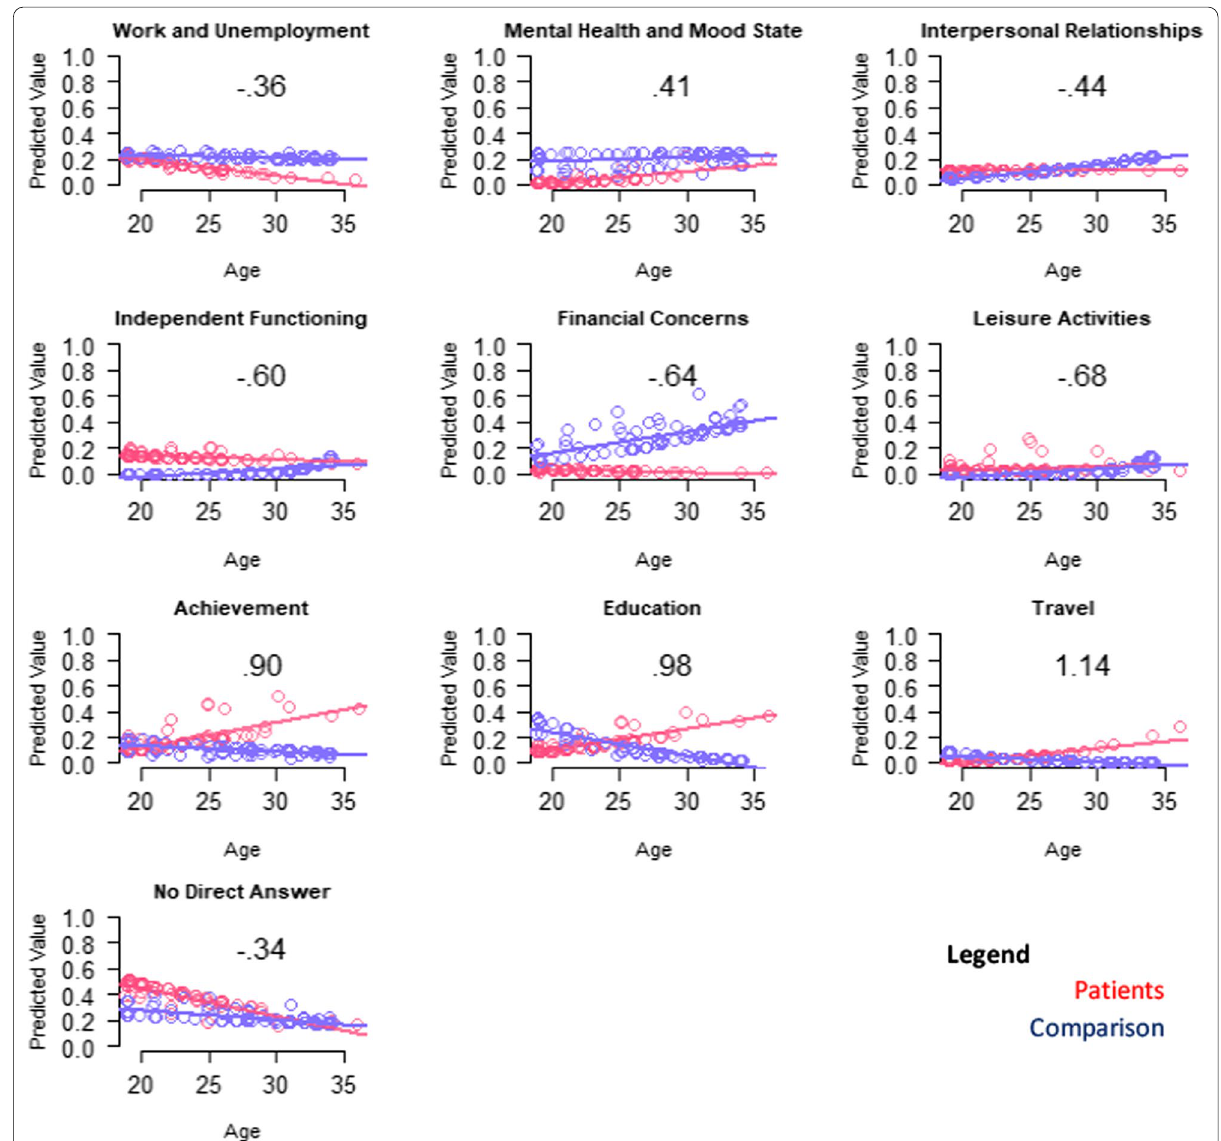
Fig. 4 Interaction plots for adjusted logistic models predicting Goal themes. Role-group differences for medium- and large-ES interaction effects are shown. Patient predicted values are shown in red; comparison in